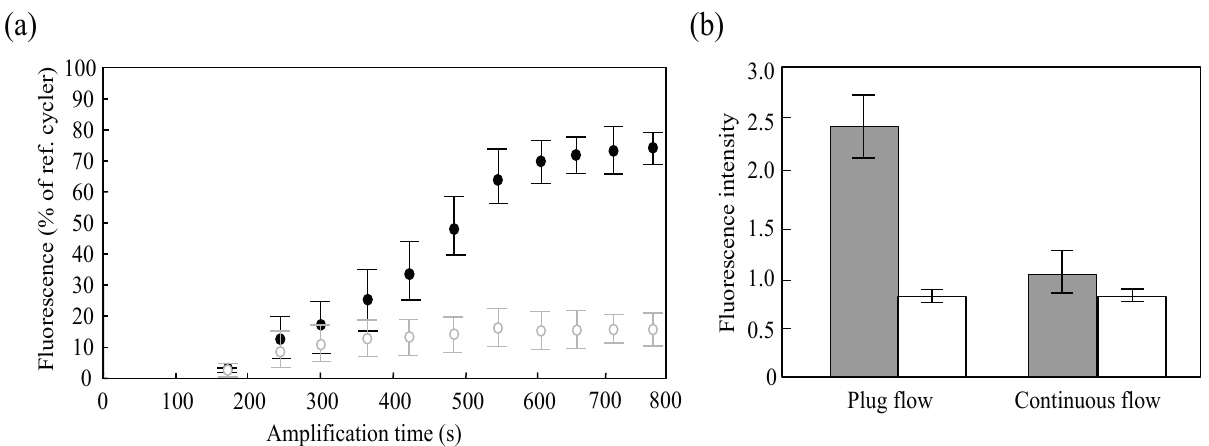
Figure 6. Amplification efficiency by the plug flow-based thermal cycling technique. ( a ) Relationship of PCR amplification yield to the thermal cycler and cycling time. The closed and open circles represent the positive and negative controls, respectively. One microliter of a fluid element passes through the microchannel for 40 cycles. All measurements were taken three times for each cycling time; ( b ) Comparison of plug-flow system and continuous-flow with a total cycling time of 600 s for 40 cycles. The gray and white bars show the positive and negative controls, respectively. All measurements were taken three times for each